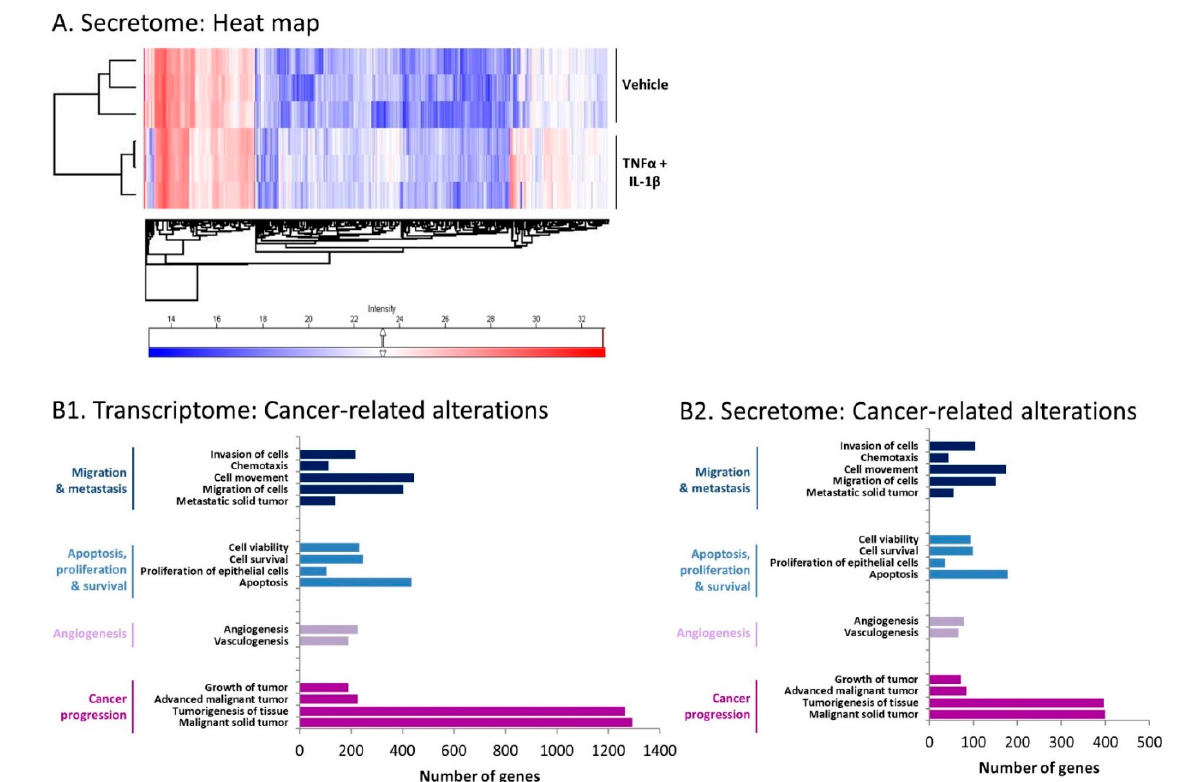
Figure 6. Following persistent stimulation of MSCs with TNF α + IL-1 β , cancer-relevant programs are promoted in the resulting inflammatory CAFs. Human MSCs were exposed to persistent TNF α + IL-1 β stimulation (concentrations as in Figure 1) or to vehicles for 14 days in transcriptome analyses and for 18–19 days in secretome analyses. ( A ) Heat maps of protein expression determined by secretome analysis of three independent biological repeats, comparing cytokine-stimulated cells and control cells. ( B ) Disorder analysis of cancer-related genes and secreted proteins for which expression was modified in cytokine-stimulated cells compared to vehicle-treated cells. ( B1 ) Gene expression data were obtained by RNAseq analysis, in which genes were filtered using a cutoff of FC > 2 or FC < 0.5, padj < 5 × 10 − 10 . ( B2 ) Data of secreted proteins were obtained by secretome analysis, in which proteins were filtered using a cutoff of FC ≥ 2 or FC ≤ 0.5, p < 0.05. The INGENUITY program was used to identify affected disorders. Indicated disorders obeyed the cutoff of p < 10 − 17 in transcriptome analyses and p < 5 × 10 − 8 in secretome analyses.